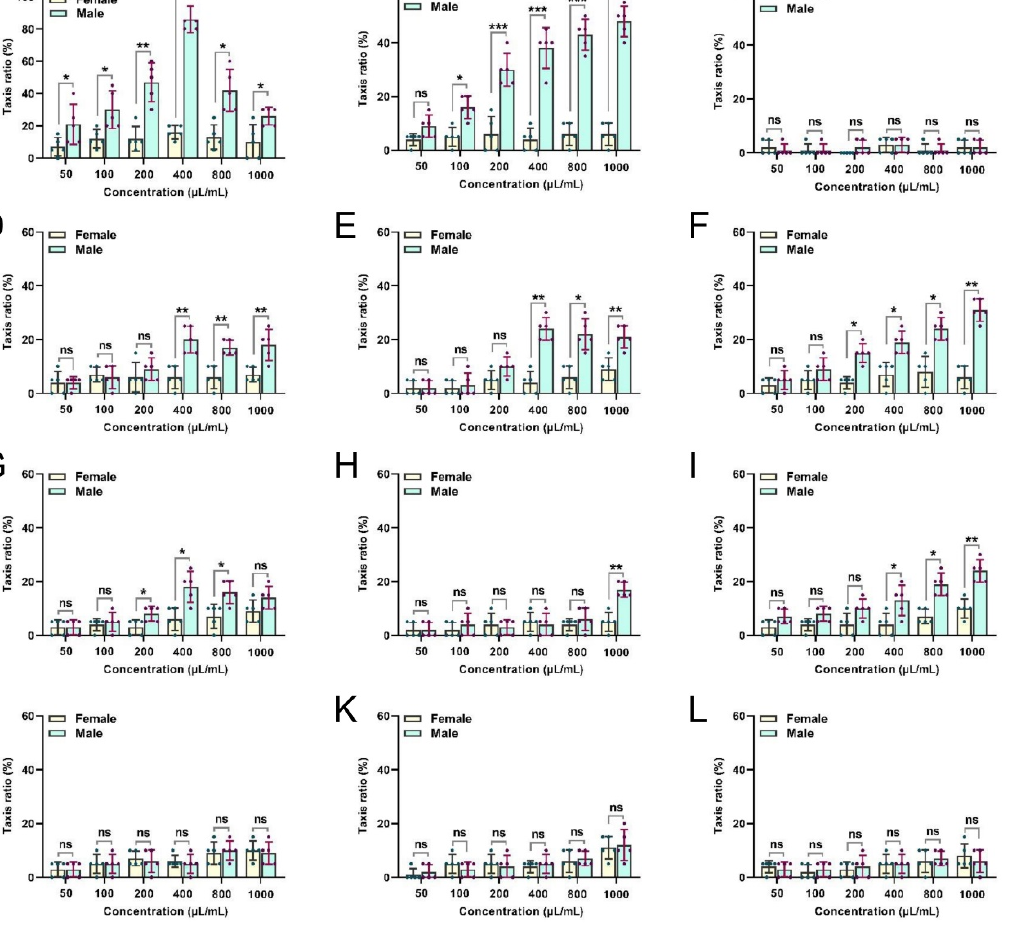
Figure 2. Comparative responsiveness of male and female flies to different concentrations of flower- derived essential oils (EOs). Responsiveness to ( A ) clove bud, ( B ) Michelia alba , ( C ) peony, ( D ) gar- denia, ( E ) peach blossom, ( F ) jasmine, ( G ) pear blossom, ( H ) chrysanthemum, ( I ) cerasus, ( J ) Rosa chinensis , ( K ) Osmanthus fragrans , and ( L ) rose EOs was tested. Each bar represents the mean ± SEM of five replicates. Asterisks indicate a significant difference between the sexes ( t ‐ tests, p < 0.05). * p < 0.05, ** p < 0.01, *** p < 0.001, ns = not significant ( p > 0.05).